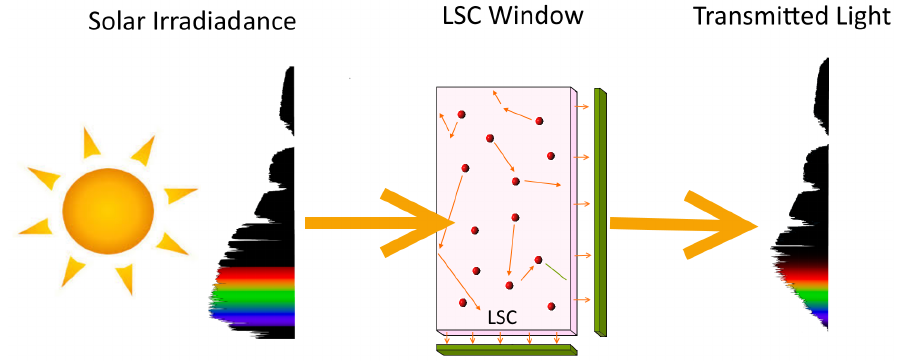
Figure 1. Schematic representation of solar radiation passing through a luminescent solar concentrator (LSC) window with 2 photovoltaic (PV) cells attached to the sides. A portion of the short wavelength has been absorbed by the LSC, changing the spectral power density (SPD) of the transmitted